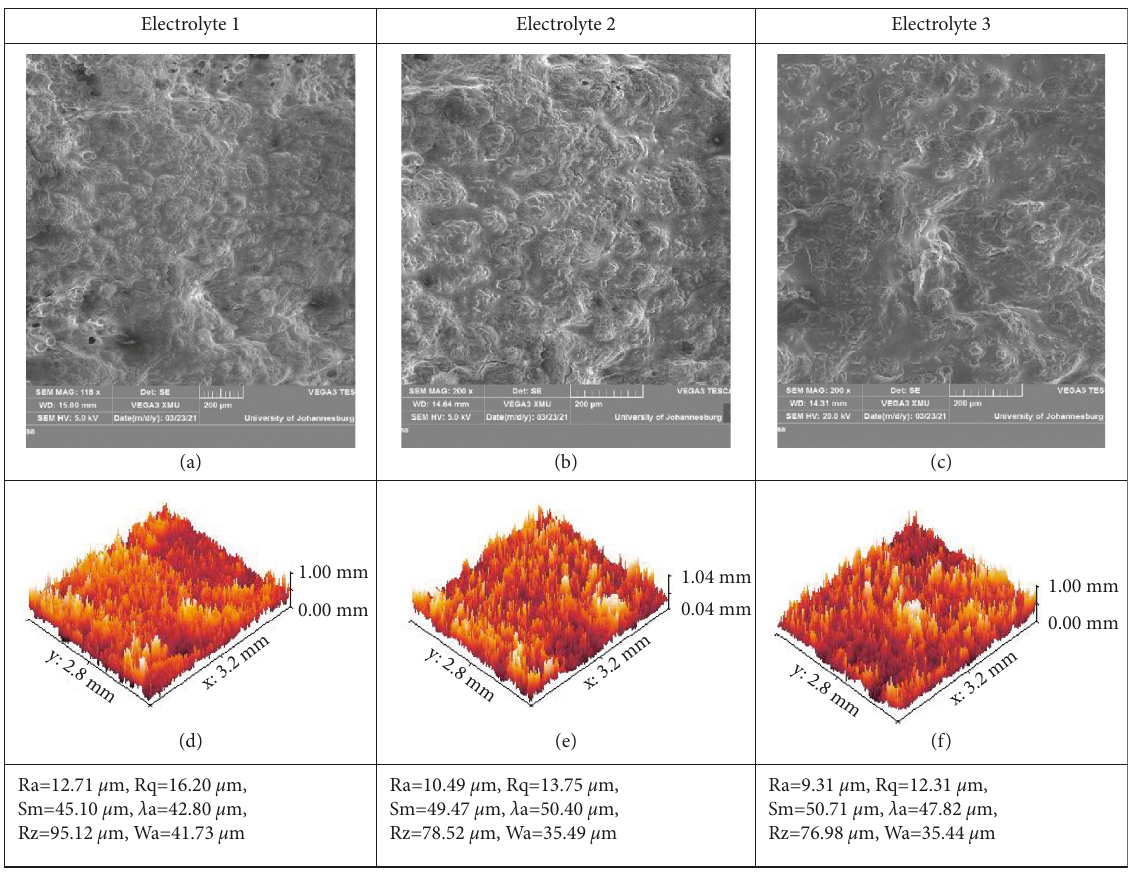
Figure 5: The SEM images electropolished Ti-6Al-4V specimen in (a) Electrolyte 1, (b) Electrolyte 2, (c) Electrolyte 3 and original 3D surface profile of specimen (d), (e), and (f) in Electrolyte 1, 2 and 3, respectively